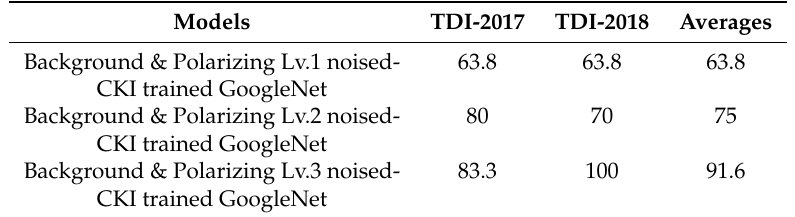
Table 2. Classification results through GoogLeNets according to the polarizing